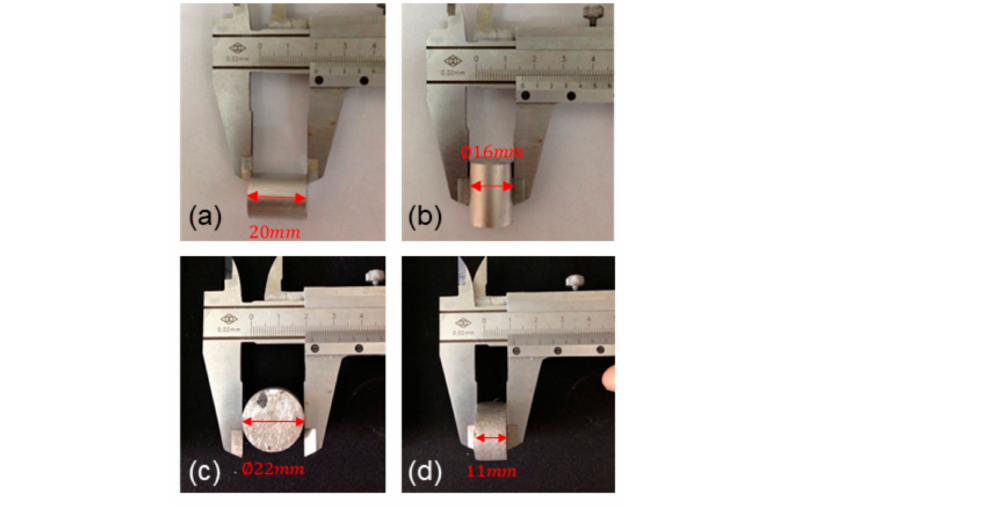
Figure 3. Geometry of the sample. ( a , b ) presents the sample before compression. ( c , d ) shows the sample after